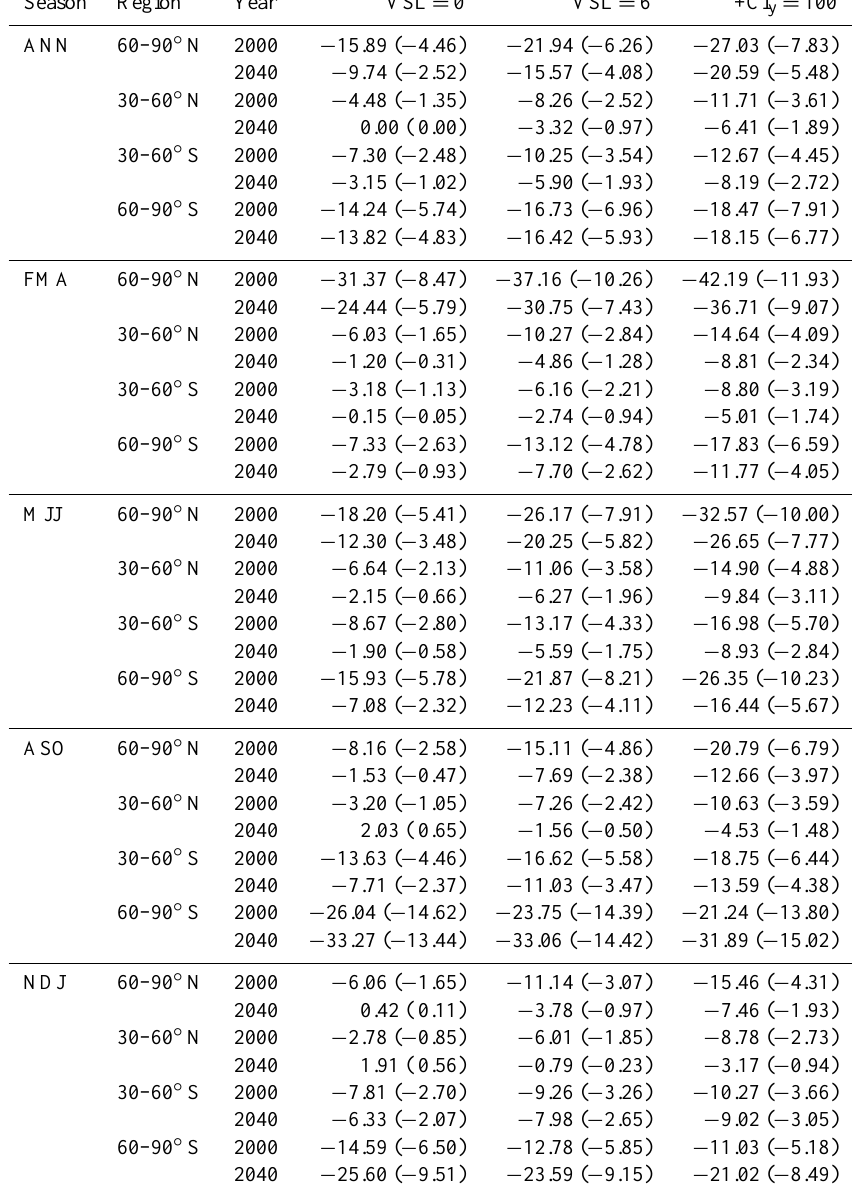
Table 1. Absolute and relative (in brackets) changes of column ozone in DU (%), between geo-engineering and baseline model simulations for varying stratospheric bromine from VSL species for the year 2000 and 2040, averaged for different latitude bands and for different